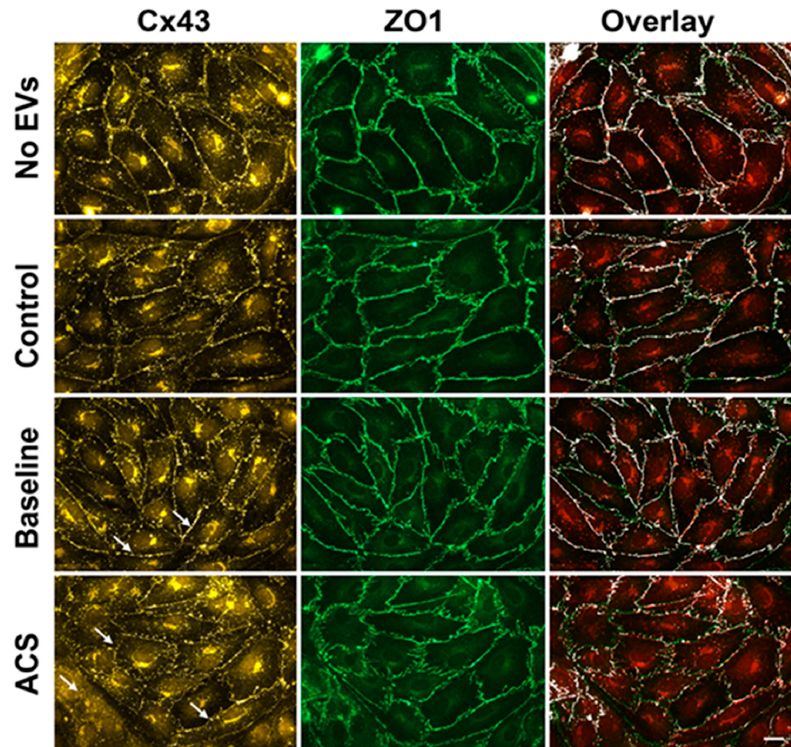
Figure 1. Localization of Cx43, ZO-1, and overlay in endothelial cells treated with EVs for 24 h. Representative photomicrographs are shown for HMVEC-D cells following 24 h treatment with no EVs, EVs from a control subject, EVs from a subject with SCD at baseline, and EVs from the same subject at the beginning of an episode of ACS. Cx43 (left panels, yellow / red) and ZO-1 (middle panels, green) were detected by immunofluorescence. The right panels show an overlay of the Cx43 and ZO-1 images (created using Image J), to demonstrate the co-localization of Cx43 and ZO-1 (co-localized points are shown in white). The amount of co-localization at the membrane decreased in the cells treated with EVs from an ACS sample. Arrows in the left panels point to the Cx43 staining at the membrane which was frequently, but not uniformly less abundant and continuous in cells treated with EVs from the subject with SCD during an episode of ACS, when compared with cells treated with EVs from the same subject at baseline. Scale bar is 20 µ